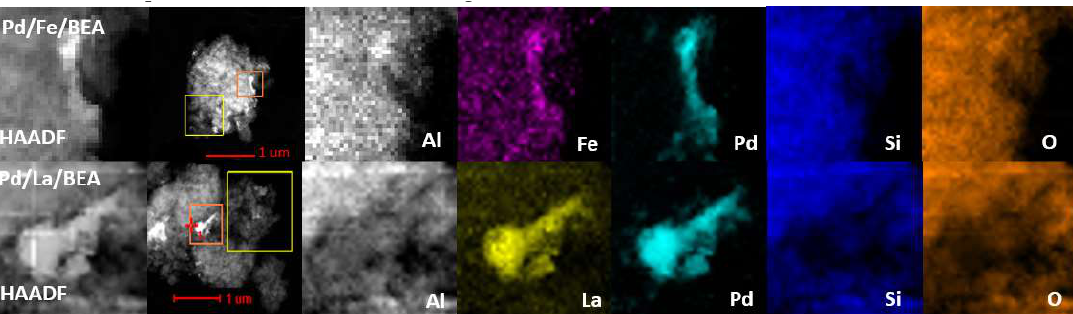
Figure 3. Transmission electron microscopy (TEM) and energy-dispersive X-ray (EDX) mapping of the samples: Pd/Fe/BEA (top row) and Pd/La/BEA (bottom row).